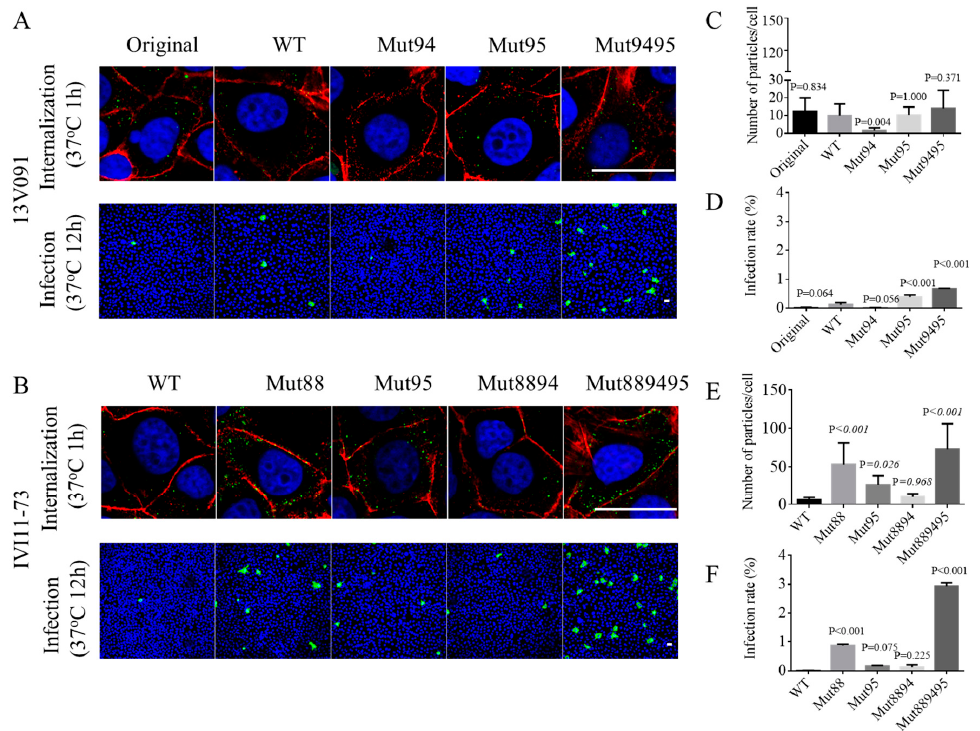
Figure 5. Immunofluorescence staining of internalized PRRSV particles 1hpi and infected MARC-145 cells at 12 hpi. Cells were inoculated with 13V091 ( A ) or IVI-1173 ( B ) original strain, WT, or their mutant variants and fixed at 1 and 12 hpi. Immunofluorescence assay was performed with mAb 13E2 against PRRSV nucleocapsid protein. Scale bar: 30 µ m. 15 cells were selected for counting the internalized particles for each condition ( C , E ). The percentage of infected cells was counted in 20 randomly selected fields covering an area of 0.55 mm 2 ( D , F ). Data were represented as M ± SD for three repeats. p values were shown for each recombinant variant or original virus in comparison with WT.